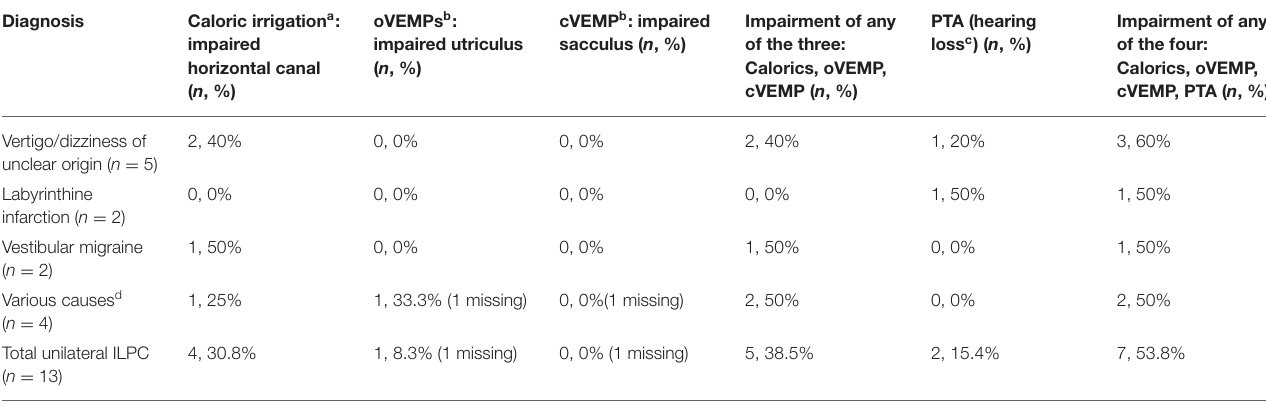
TABLE 3 | Ipsilesional vestibulo-cochlear involvement in patients with unilateral ILPC on vHIT.